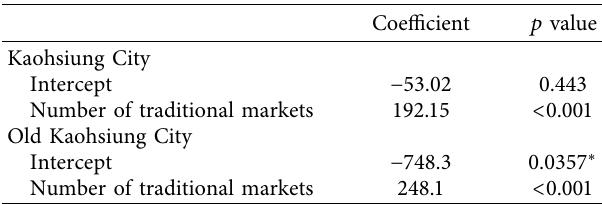
Figure 6: The dengue infection cases in Kaohsiung City in 2014–2015 (a). The locations of the traditional market of Kaohsiung City (b). Table 1: Regression analysis of dengue infection cases and tra- ditional